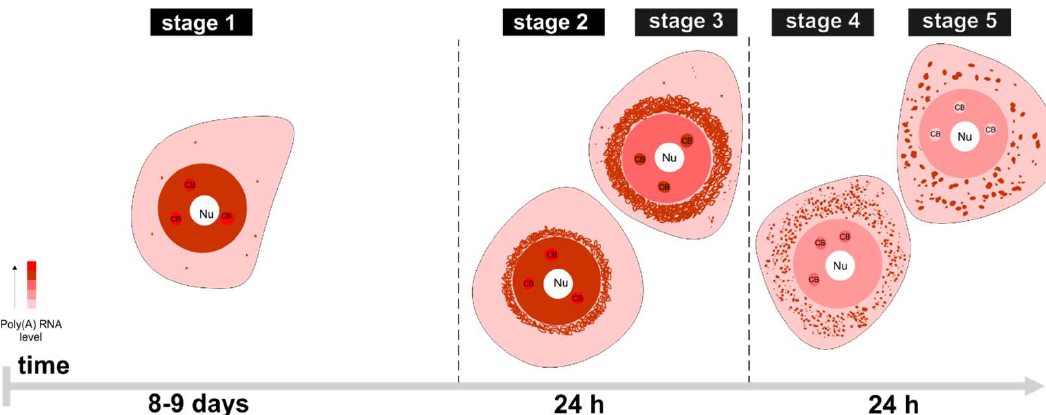
Figure 1. The stages of poly(A) RNA cycle. Poly(A) RNA is localized almost exclusively in nucleus (both in nucleoplasm and Cajal bodies (CBs)) during the first stage in which transcription occurs. At the second and third stage poly(A) RNA is transferred to cytoplasm; during the former, poly(A) RNA is still present in nucleus in large quantities, while during the latter stage, the majority is already exported. The fourth and fifth stage are characterized by low levels of poly(A) RNA in nucleoplasm and high levels in cytoplasm, and in the fifth one there is no polyadenylated RNA in CBs. CB—Cajal body, Nu—nucleolus.